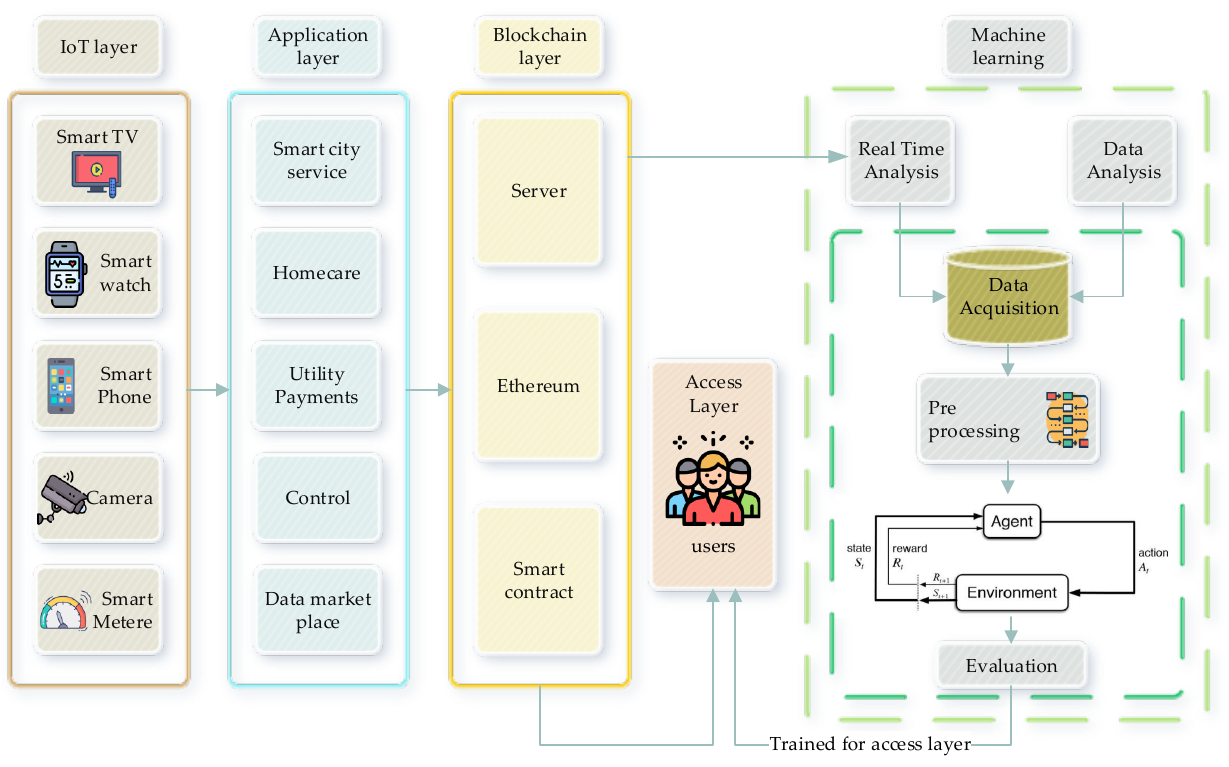
Figure 1. Smart home architecture based on combination of machine learning and